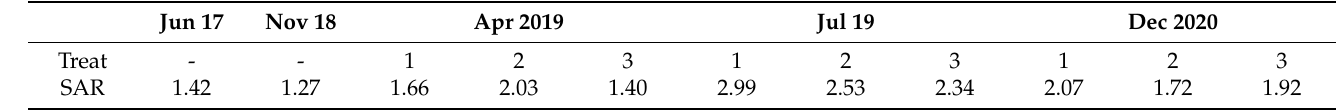
Table 5. SAR values per date and treatment 1: RWSDI, reclaimed water plus subsurface drip; 2: RWDI, reclaimed water plus surface drip; 3: CWSDI, conventional water plus subsurface drip irrigation.